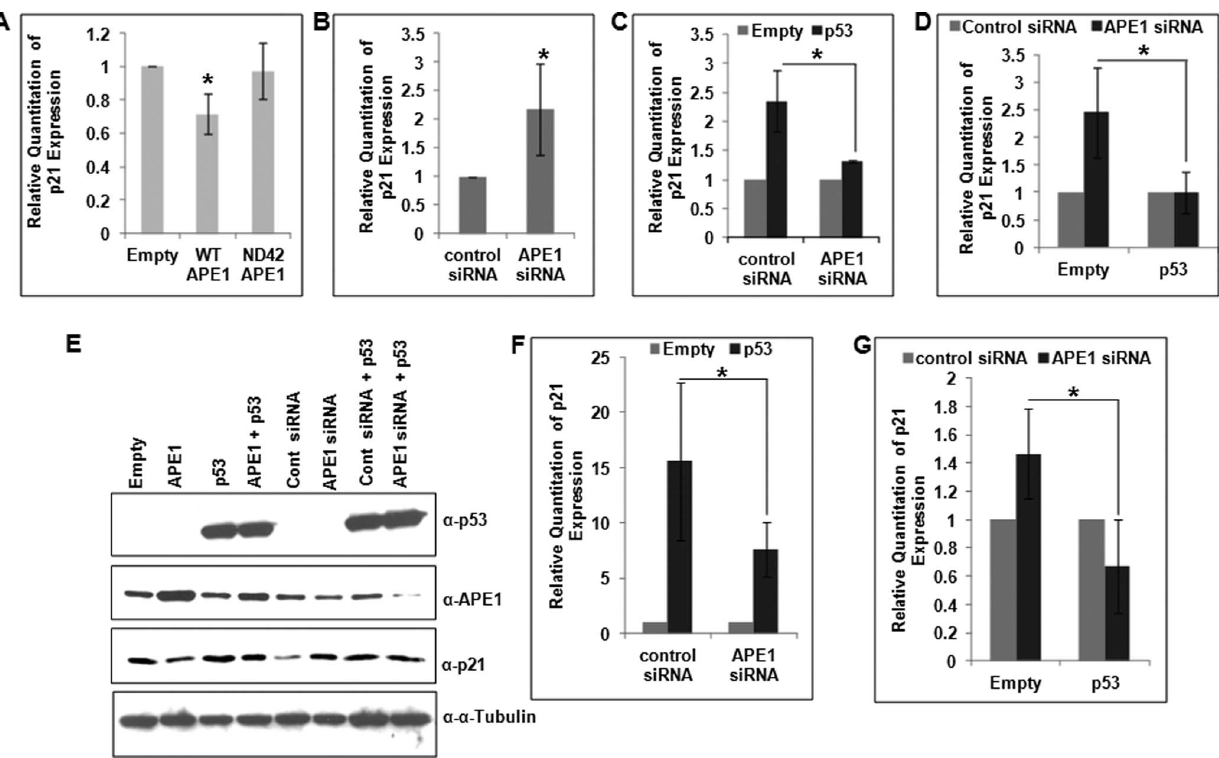
Figure 3. Repression of p21 by APE1 in p53-null cells and effect of ectopic p53 in this repression. ( A & B ) Real Time RT-PCR analysis showing relative quantitation of p21 transcript level in (A ) HCT116 p53null cells with WT and N D 42 APE1 overexpression; *: p value (n=4) calculated from control (empty vector transfection) vs. WT or N D 42 APE1 overexpression, and ( B ) control (control siRNA) vs. APE1-depleted HCT116 p53null cells; *: p value , 0.05 (n=4) calculated from control vs. APE1-depleted cells. ( C ) Effect of ectopic p53 expression on p21 transcript level in control vs. APE1- depleted HCT116 p53null cells. First, cells were transfected with control siRNA or APE1 siRNA, the next day both the cell types were again transfected with empty vector or p53 expression vector and after 48 hrs the cells were harvested; signal from empty vector transfection in both control and APE1-depleted cells were set as reference samples; *: p value , 0.05 (n=3) calculated based on the effect of ectopic p53 expression over empty vector transfection in control vs. APE1-depleted cells. ( D ) Effect of APE1 depletion in control (empty vector transfected) vs. ectopic p53-expressing HCT116 p53null cells; the same experiment was performed as in C but analyzed differently; signal from control siRNA-transfected cells in both empty vector transfected and ectopic p53 expressing cases were set as reference samples; *: p value , 0.05 (n=3) calculated based on the effect of APE1- depletion in empty vector transfected vs. ectopic p53 expressing cells. ( E ) Representative Western analysis of p53, APE1, p21 and a -Tubulin levels in the same HCT116 p53null cells as in B–D. ( F & G ) Real Time RT-PCR analysis of p21 level in Saos2 cells as in C & D. *: p value , 0.05 (n=2).